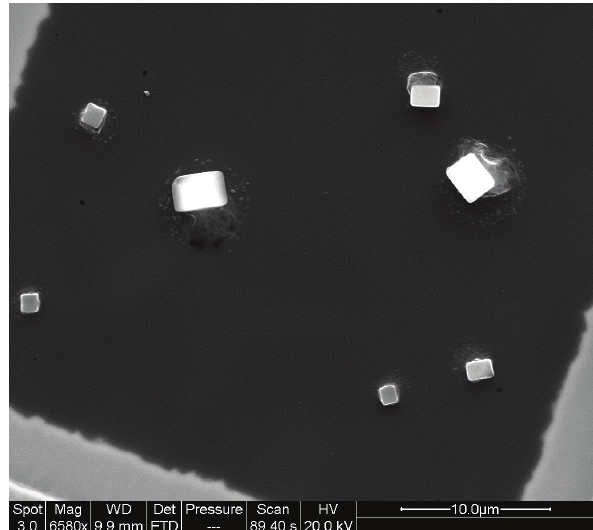
Figure 7. SEM image of aerosol particles collected on 1 March 2014 above the sea-ice area with frost